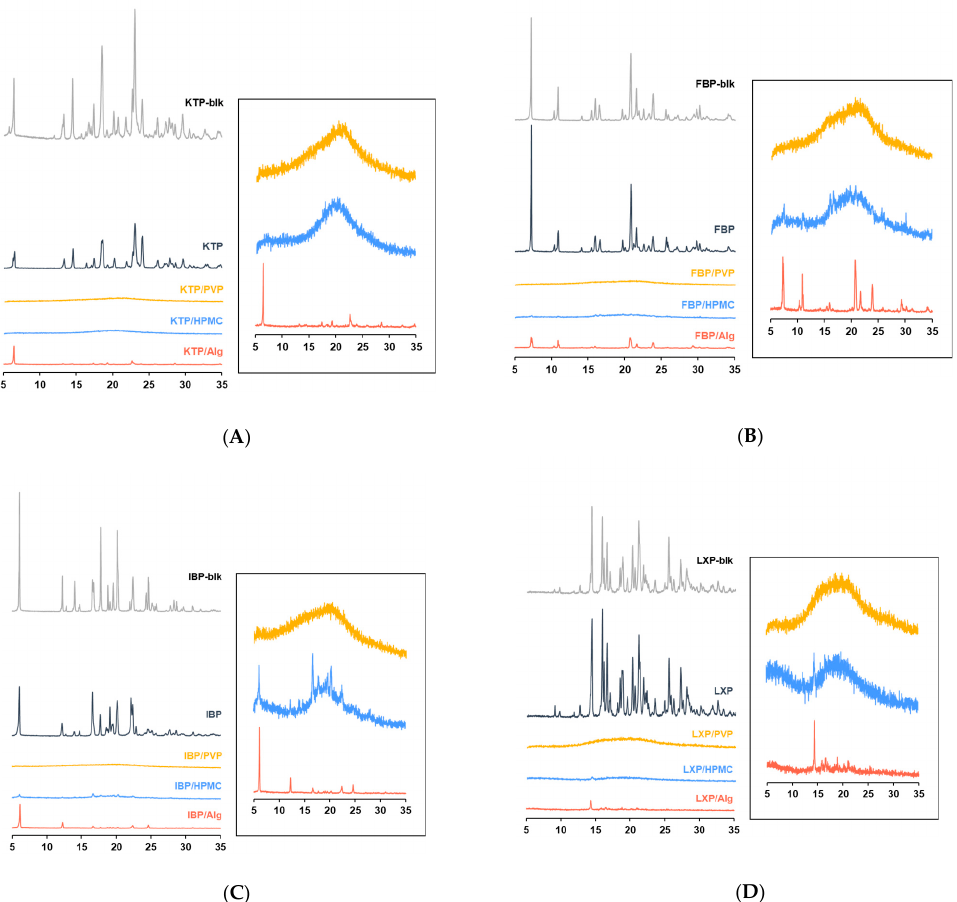
Figure 3. Powder X-ray diffraction (PXRD) spectra of film formulations for ( A ) KTP, ( B ) FBP, ( C ) IBP, and ( D ) LXP. Spectra indicated for API bulk (gray), control solid formulation derived from API alone (black), film formulation of API with PVP (yellow), film formulation of API with HPMC (blue), and film formulation of API with Alg (orange). The right panels show the enlarged